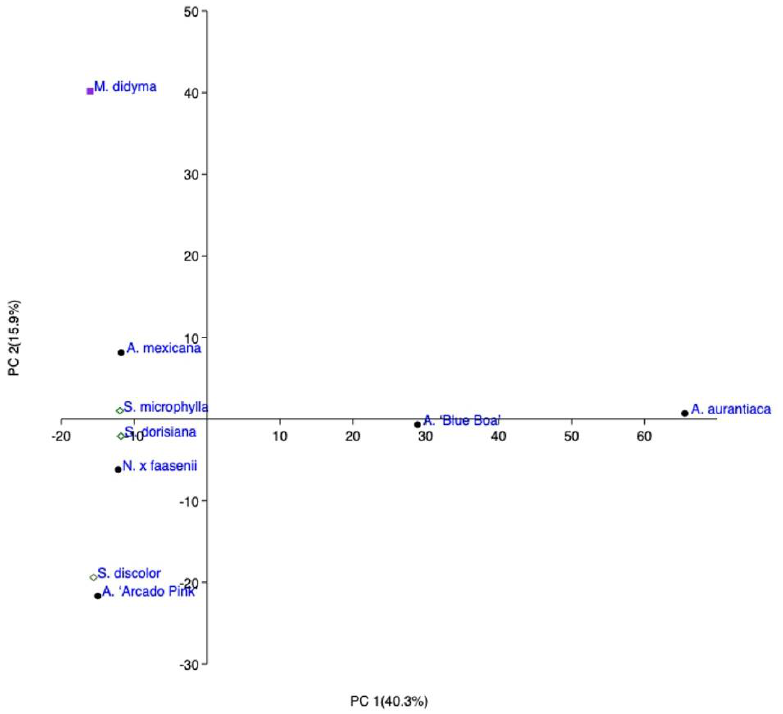
Figure 3. Principal Cluster Analysis (PCA) of the EOs obtained from all the studied plants belonging to the Mentheae tribe.